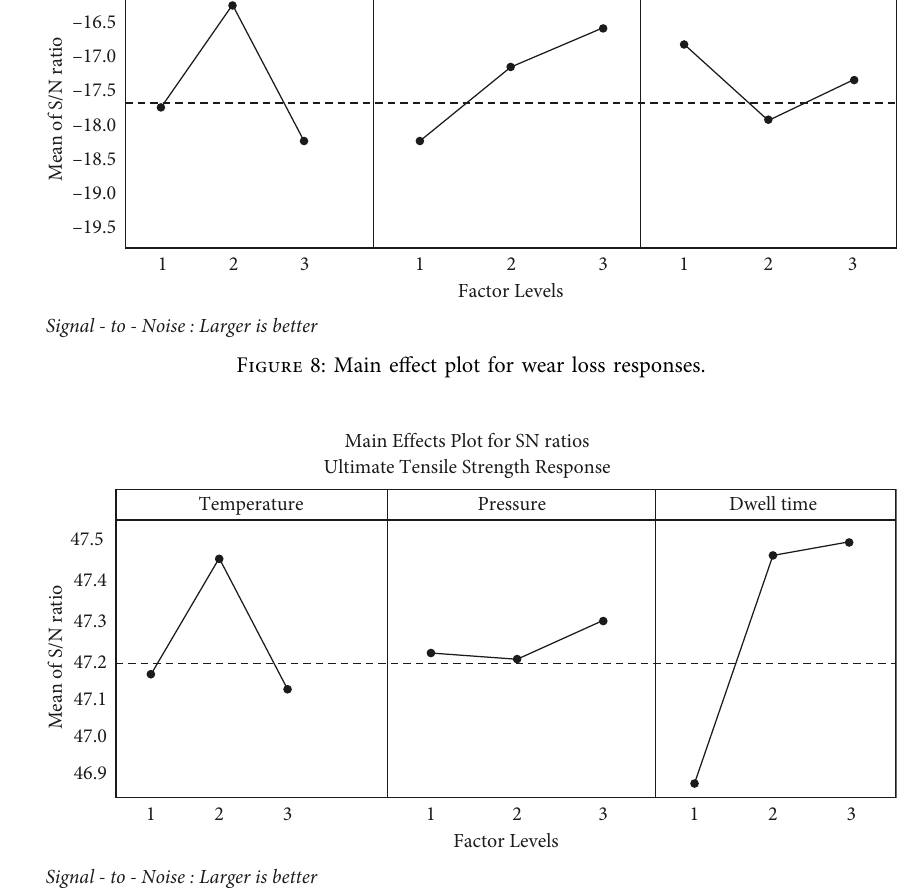
Figure 9: Main effect plot for wear